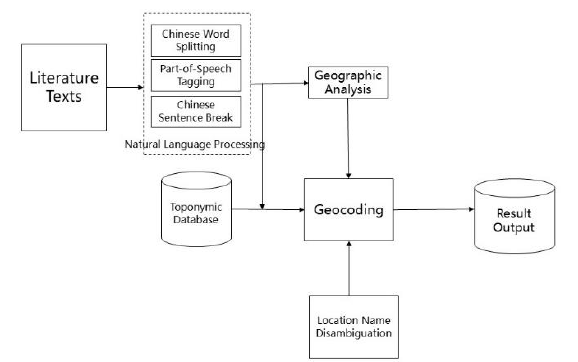
Figure 5 . Geographical entity extraction technology